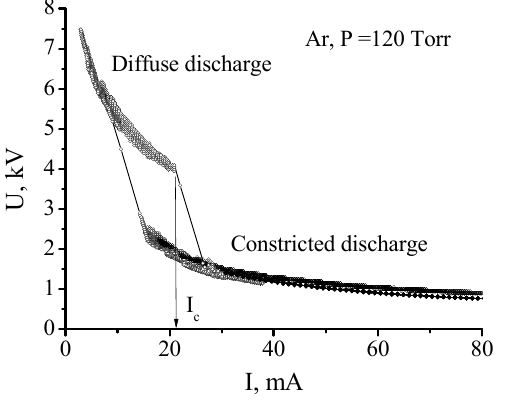
Figure 8. Volt-amp characteristic of the discharge under constriction [47]. (© IOP Publishing. Reproduced with permission. All rights reserved.)